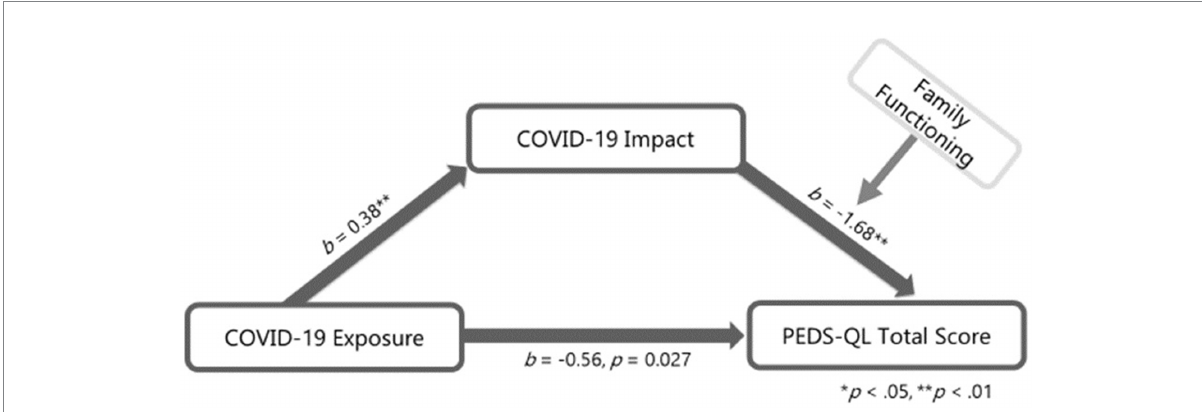
FIGURE 2 Quality of life moderated mediation. Interaction between COVID-19 Impact and family functioning b = 0.03, p = 0.02; r -squared for the model: 0.26; index of moderated mediation = 0.01, 95% CI [0.001, 0.02]; this model controls for age, gender, ethnicity and prior family of which income and ethnicity was significantly associated with PEDS-QL total score.